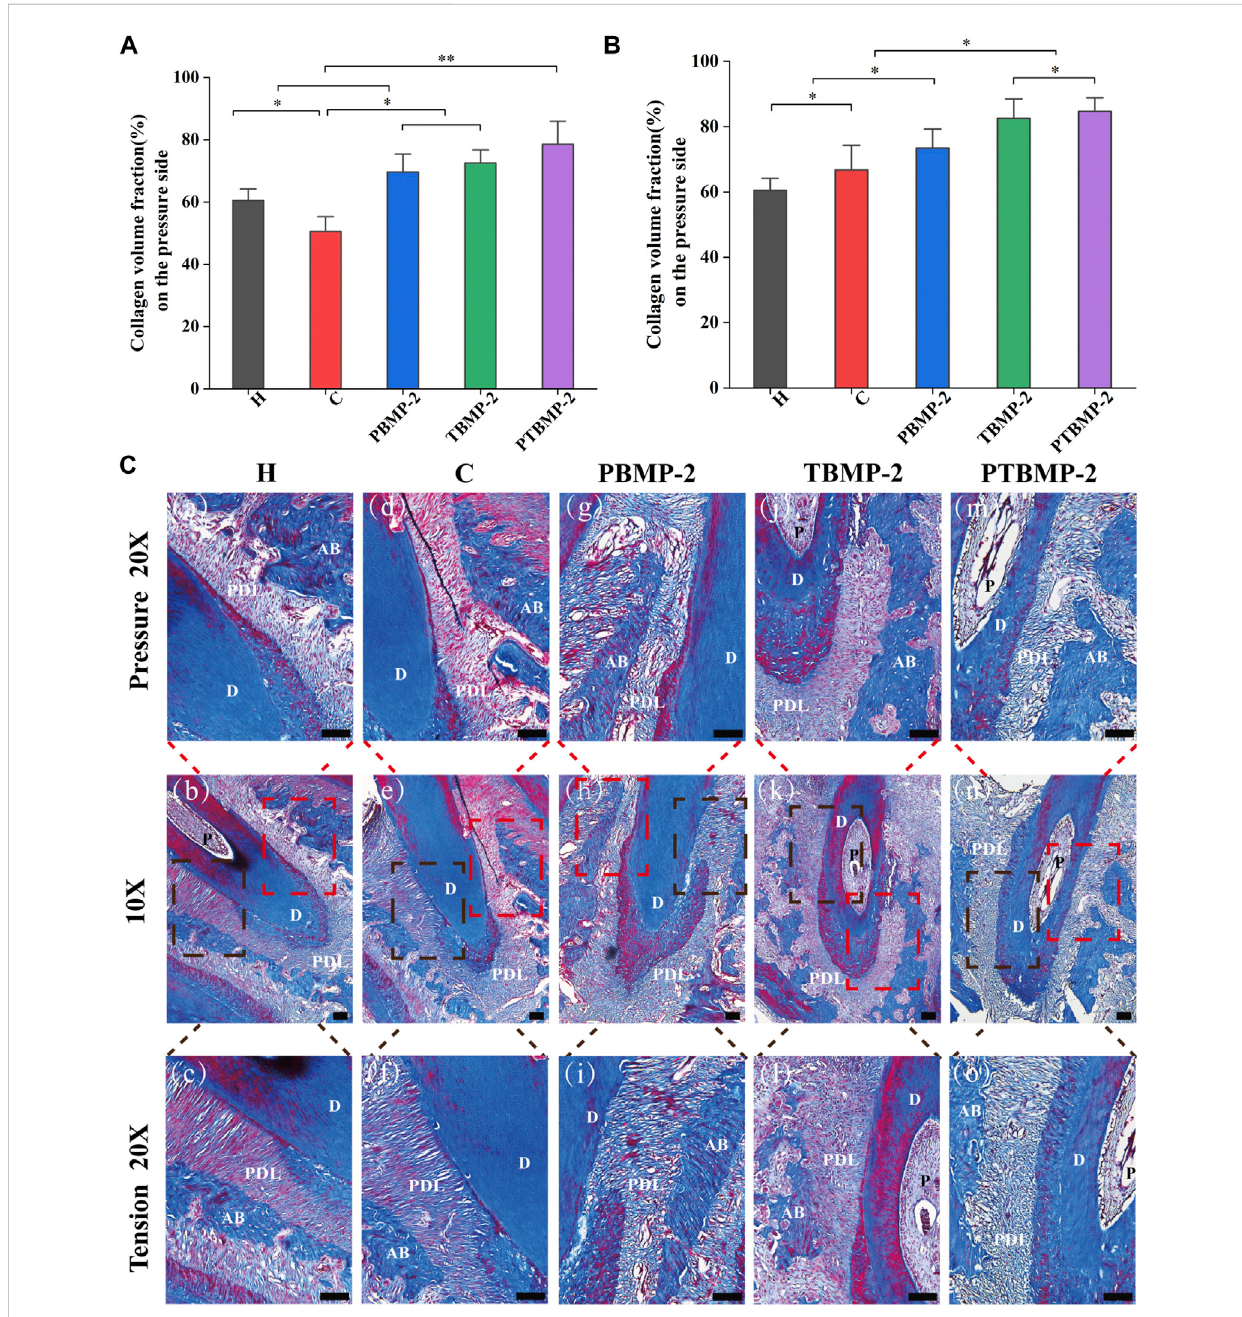
FIGURE 7 Histological measurement of collagen fi ber content on Masson-stained sections. The periodontal ligament was measured on the pressure (A) and tension (B) sides of the mesial root of M1. The collagen volume fraction (CVF) of each side was measured on three standard fi elds and averaged. Data are presented as mean and standard deviation. *Signi fi cant ( p < 0.05) difference between groups, **Signi fi cant ( p < 0.01) difference between groups. Light micrographs of sagittal Masson-stained sections of the mesial root of left maxillary fi rst molar (M1) in ×10 magni fi cation and ×20 magni fi cation on thepressure andtension sides (C) .Red boxes, periodontal tissue ofpressure side; blackboxes, periodontal tissue oftension side.Scale bar= 100 μ m.AB, alveolar bone; D, dentin; PDL, periodontal